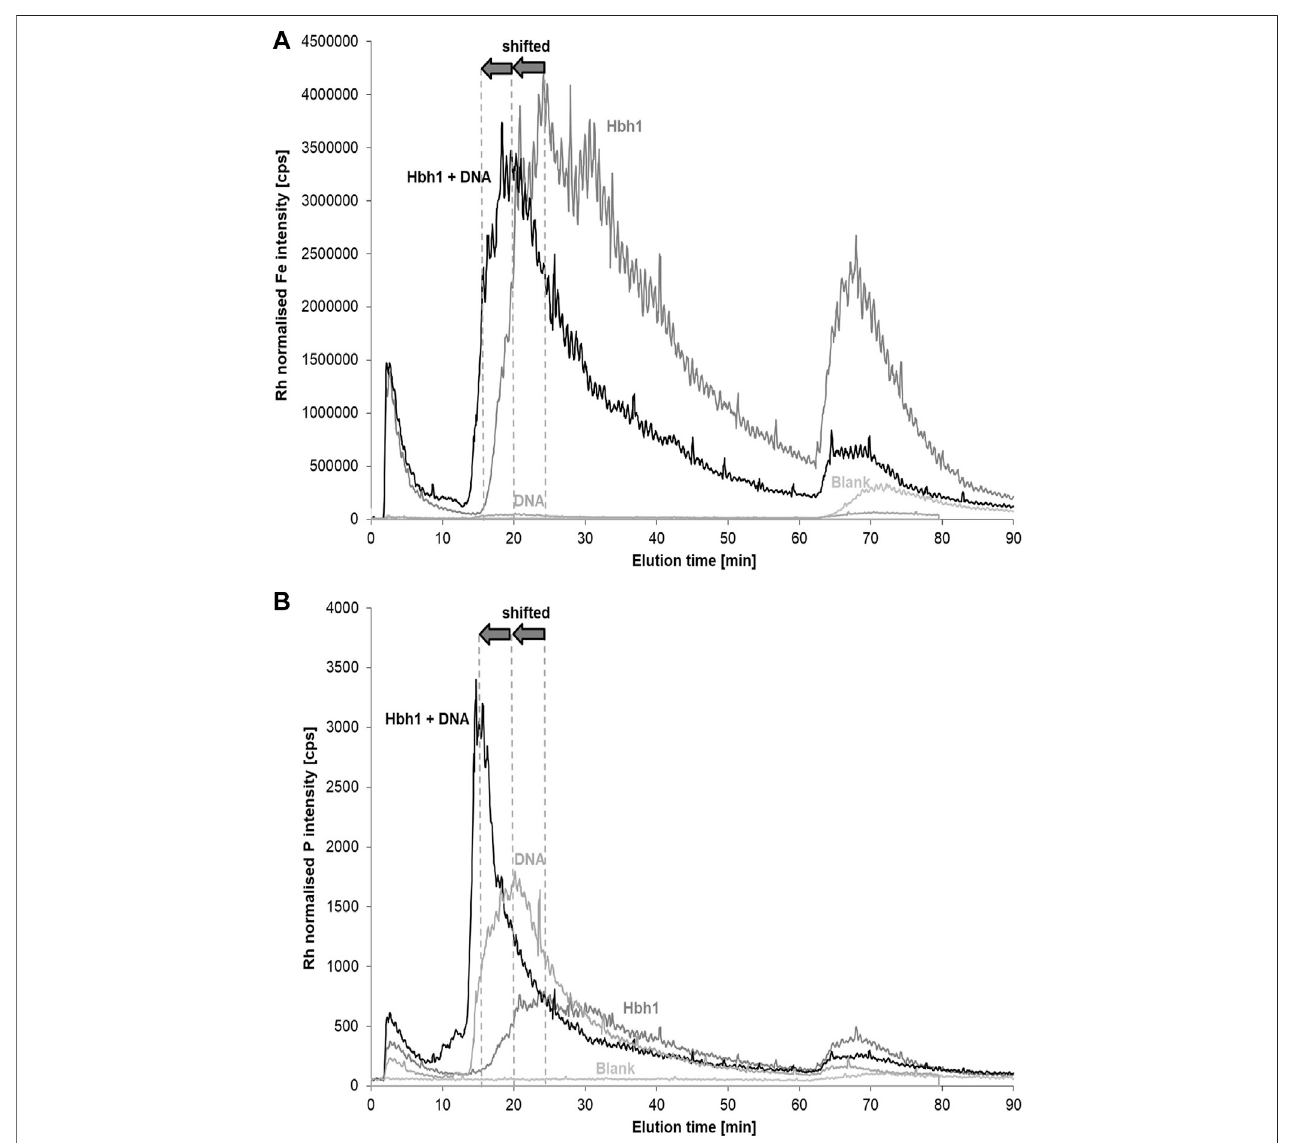
FIGURE 4 | Fractograms of a surface-water sample (Hbh1), calf-thymus DNA in deionized water, the surface-water sample spiked with CT DNA, and a deionized water blank monitoring Fe (A) and P (B) . The carrier was 25 μ mol L − 1 NaCl and the membrane 1 kDa PES.